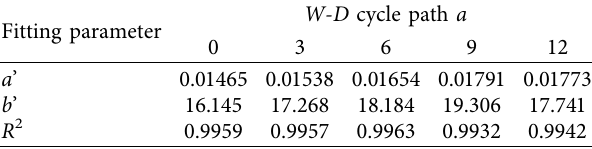
c d and d of W - D cycle path a